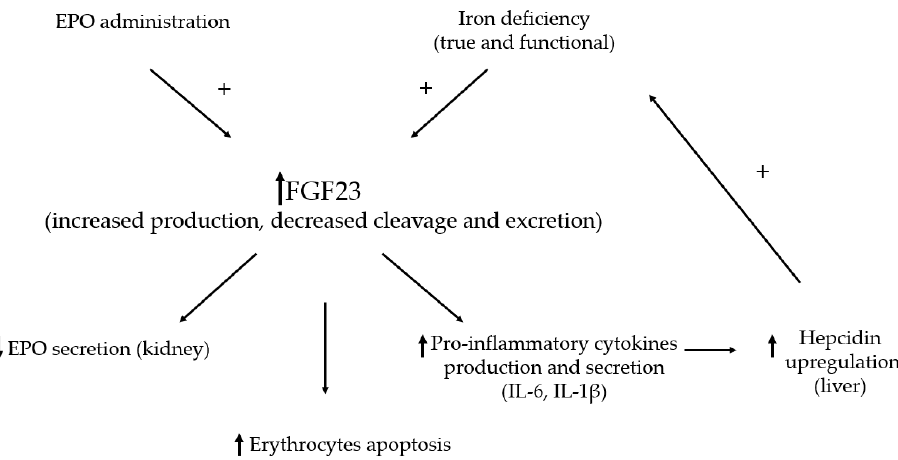
Figure 2. FGF23 and anemia in chronic kidney disease. Abbreviations: EPO—erythropoietin, IL ‐ 6— interleukin 6, IL ‐ 1 β —interleukin 1 beta. The symbol “+” indicate an enhancing effect, arrows ↑ and ↓ indicate an increase and decrease respectively.